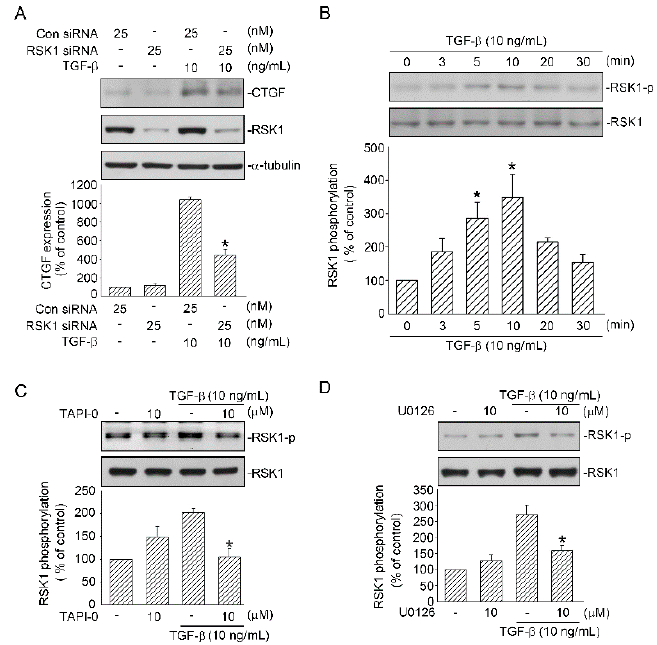
Figure 4. Involvement of RSK1 activation in TGF- β -induced CTGF expression through the Figure ERK/ADAM17 pathway in human lung epithelial A549 cells. ( A ) Cells were transfected with 25 nM control siRNA (con siRNA) and 25 nM RSK1 siRNA for 48 h before they were stimulated with TGF- β (10 ng/mL) for an additional 6 h. Cell lysates were prepared, and specific antibodies for CTGF and α -tubulin were detected through Western blotting. Results are expressed as mean ± SEM of three independent experiments. * p < 0.05, compared with TGF- β plus the control siRNA group. ( B ) Cells were stimulated with TGF- β (10 ng/mL) for 0–30 min, and then the levels of RSK1 phosphorylation